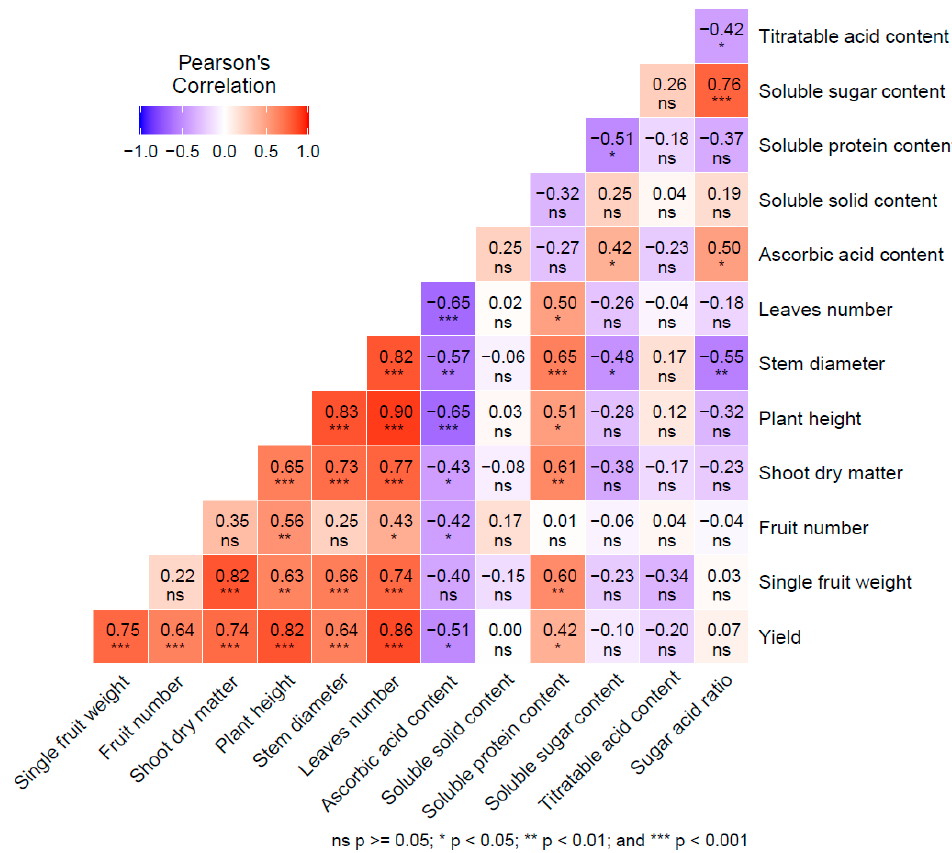
Figure 4. The Pearson’s correlation coefficients for fruit yield, single fruit weight, fruit number, shoot dry matter, plant height, stem diameter, leaves number, ascorbic acid content, soluble solid content, soluble protein content, soluble sugar content, and titratable acid content. The color gradient is proportional to the Pearson’s correlation coefficient. Red and blue color denote positive and negative correlations, respectively. ns p ≥ 0.05; * p < 0.05; ** p < 0.01; *** p < 0.001.